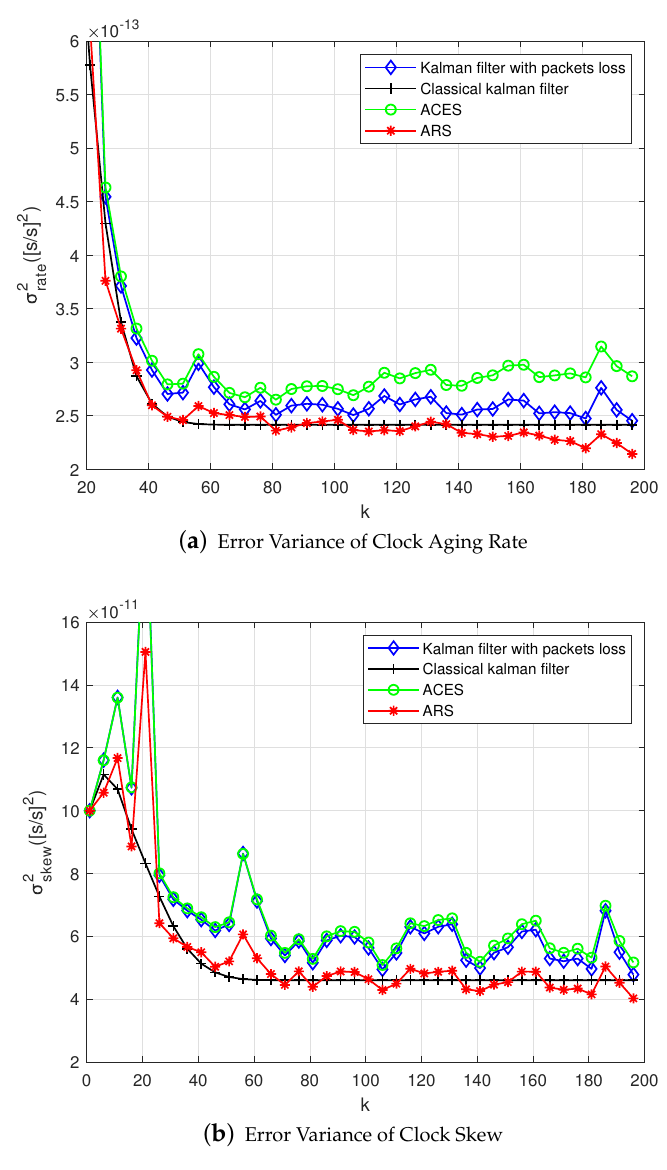
Figure 8. Error Variance of the Second-order Kalman Filter in Single-hop